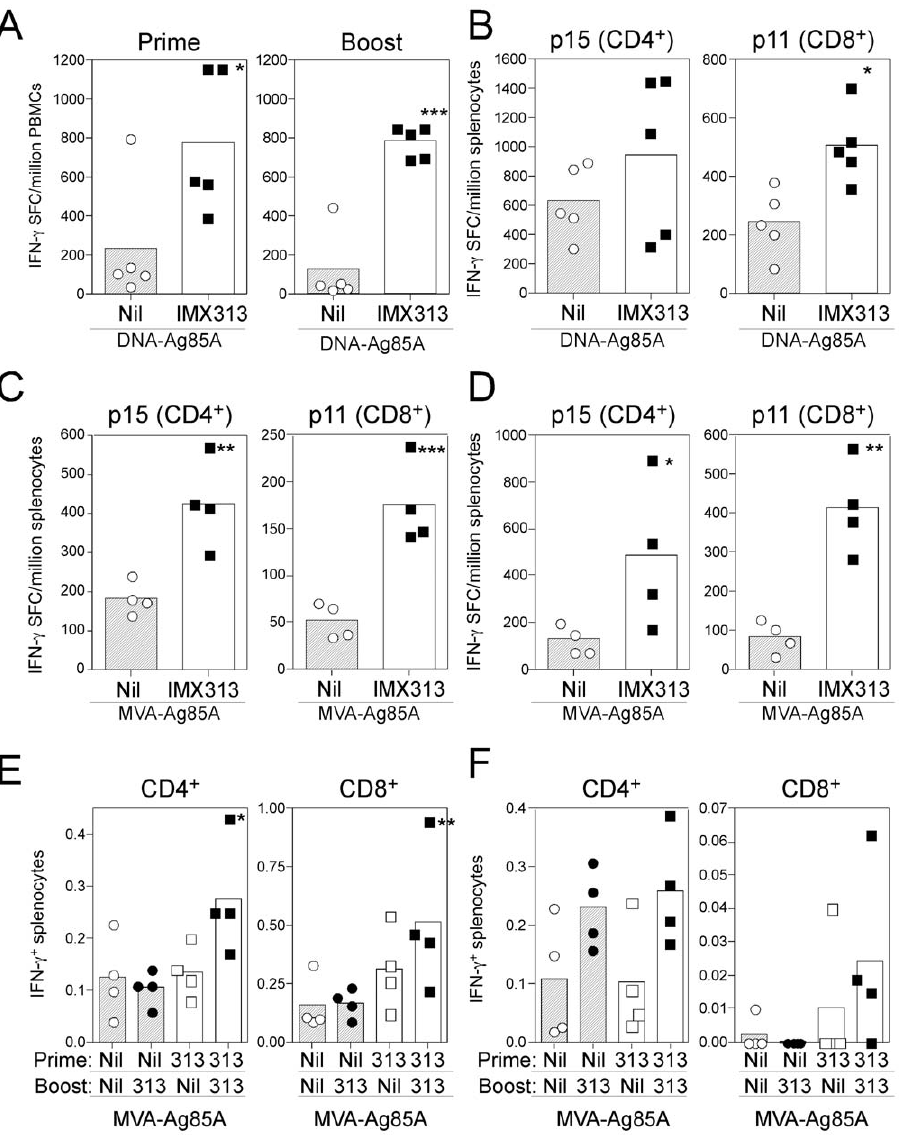
Figure 2. Screening of DNA and MVA vaccines in mice. A & B ) Balb/c mice were immunized i.m. at weeks 0 and 2 with 50 m g of pSG2-Ag85A or pSG2-Ag85A IMX313. IFN- c ELISpot was used to measure the response to the p15 and p11 peptides (together) in the blood 12 days after each vaccination ( A ) of each individual peptide in the spleen 14 days after the final vaccination ( B ). C & D ) In two separate experiments, Balb/c mice were immunized i.m. ( C ) or i.d. ( D ) with 10 6 PFU of MVA-Ag85A or MVA-Ag85A IMX313 and the response to p15 and p11 measured in the spleen of all animals 7 days later. E & F ) Balb/c ( E ) or C57BL/6 ( F ) mice were immunized i.m. with 10 6 PFU of MVA-Ag85A or of MVA-Ag85A IMX313 at weeks 0 and 2. Intracellular cytokine staining was performed on spleen samples taken 2 weeks after the final vaccination. Graphs represent the frequency of IFN- c producing CD4 + (left) or CD8 + (right) T cells in response to a single pool containing all Ag85A peptides. For all graphs, the bar represents the mean per group with each individual animal displayed as a single point. Data were analyzed with a 2-way analysis of variance; fusion to IMX313 was shown to induce a significant effect in all data sets ( A p , 0.001, B p=0.0298, C p , 0.001, D p=0.0002, E p=0.0017, F p=0.0415). No interaction between prime/boost or CD4 + /CD8 + T cell responses were observed in any experiment and when analyzed with a post-hoc Bonferroni test; the asterisks denote the level of statistical significance (*p , 0.05, **p , 0.01, ***p , 0.001).